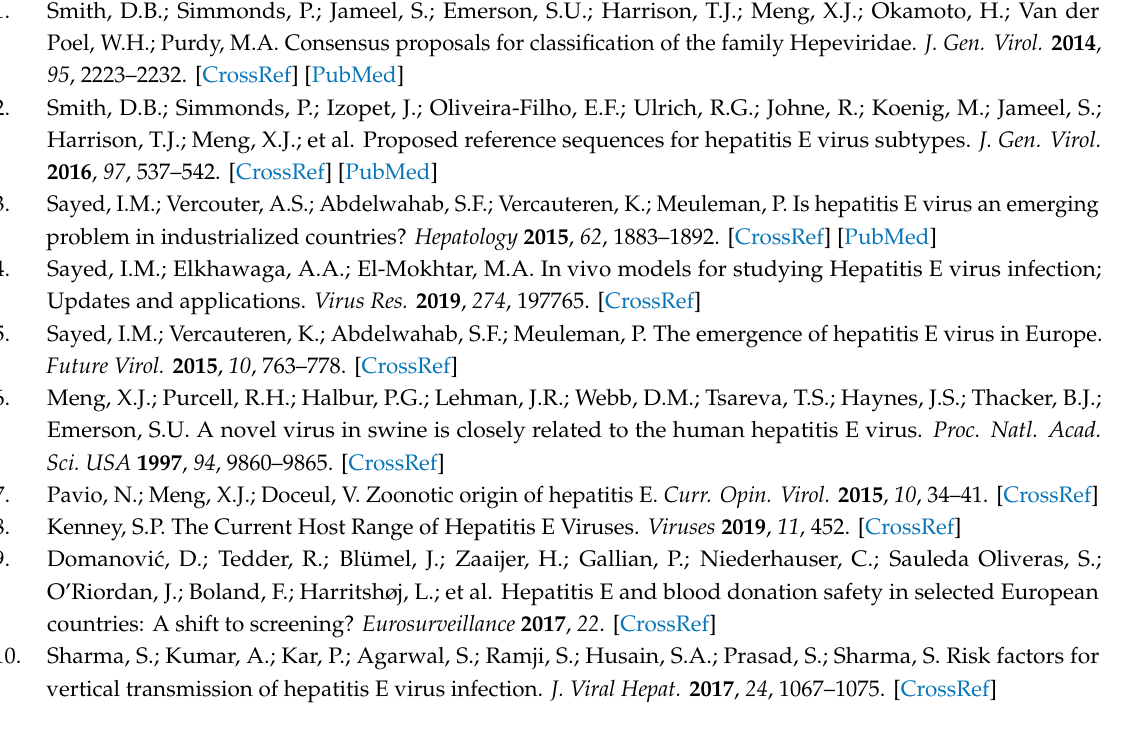
Figure S1: Infection of the CD10 + / CD13 + PT epithelial cells and PBMCs with UV-inactivated HEV inoculum. Infection of polarized CD10 + / CD13 PT cells (A) and / or PBMCs (B) with UV-inactivated HEV-1 inoculum. Intracellular (dotted line) and extracellular (solid line) HEV RNA was quantified by qPCR. LOQ: limit of quantification. Depicted are the mean values of three independent experiments ± SEM. Figure S2: E ff ect of UV inactivated HEV-1 on the coculture of PBMCs with the PT epithelial cells CD10 + / CD13 + PT cells were challenged with UV-inactivated HEV-1 for 7 days and then PBMCs from the same donors were added for an additional 3 days. Total cellular RNA was extracted from the PT cells and the mRNA expression level of proinflammatory markers (IL-8, IL-6, MCP-1, TNF- α , and IL-1 β ) (A), chemokines (Cxcl-9, Cxcl-10, and Cxcl-11) (B), and kidney injury transcripts (KIM-1, NGAL, and IL-18) (C) were assessed. The relative gene expression was determined by comparing the expression levels of these transcripts with mock cells (PT + PBMCs). Black columns represent unchallenged cells, and grey columns represent UV inactivated HEV challenged cells, Table S1: The sequences of the primers used in the